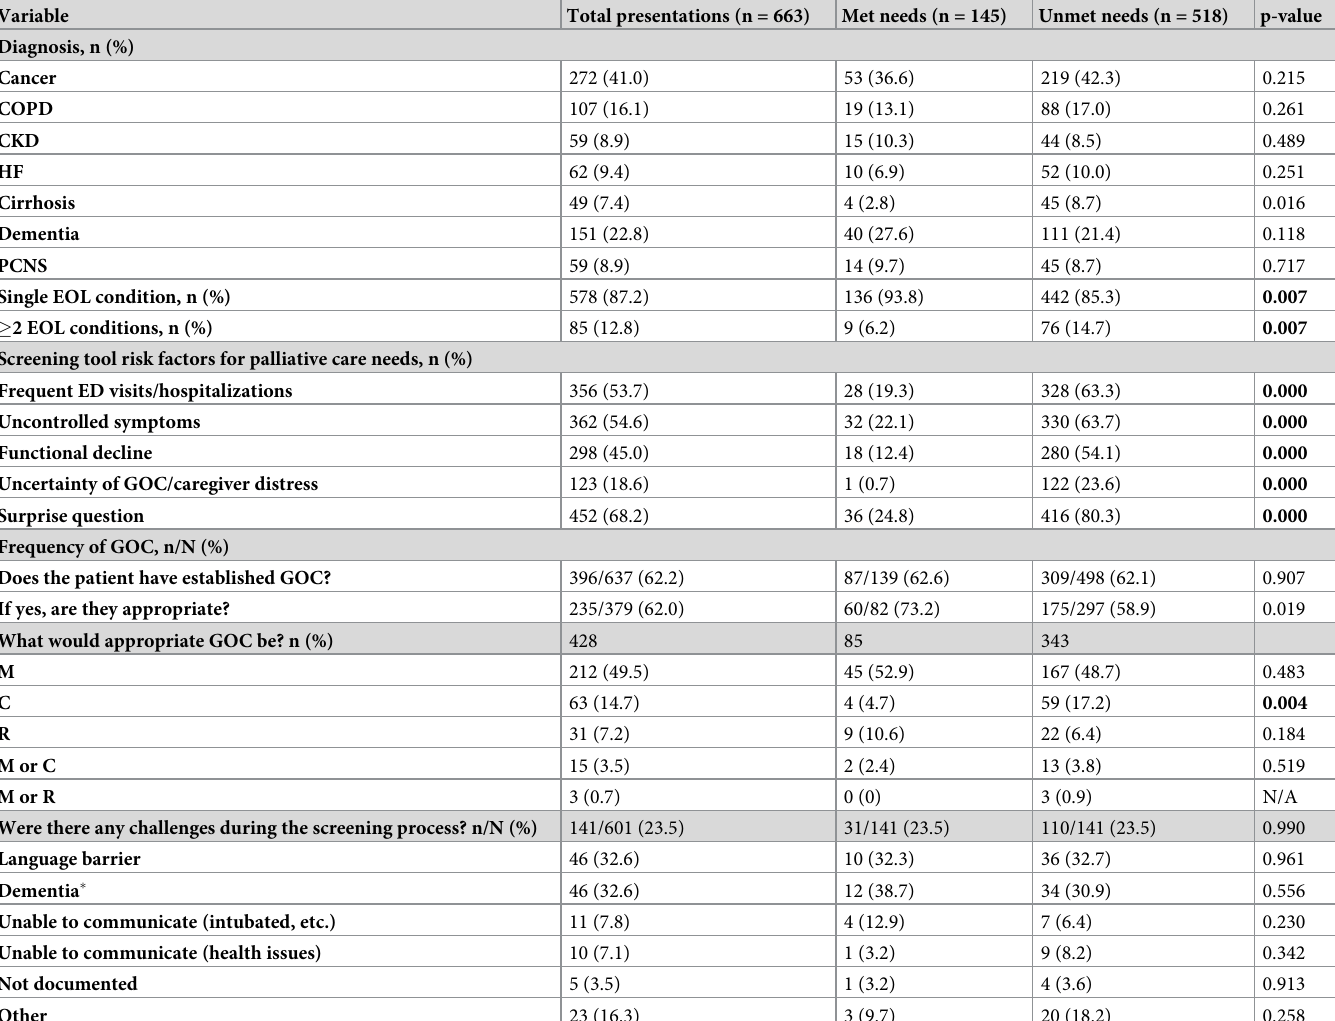
Table 2. Factors included in a modified screening tool to identify met or unmet palliative care needs among 663 presentations to the emergency department by patients with end-of-life